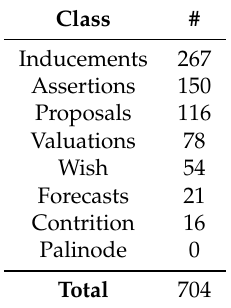
Table 1. Number of tweets by illocution